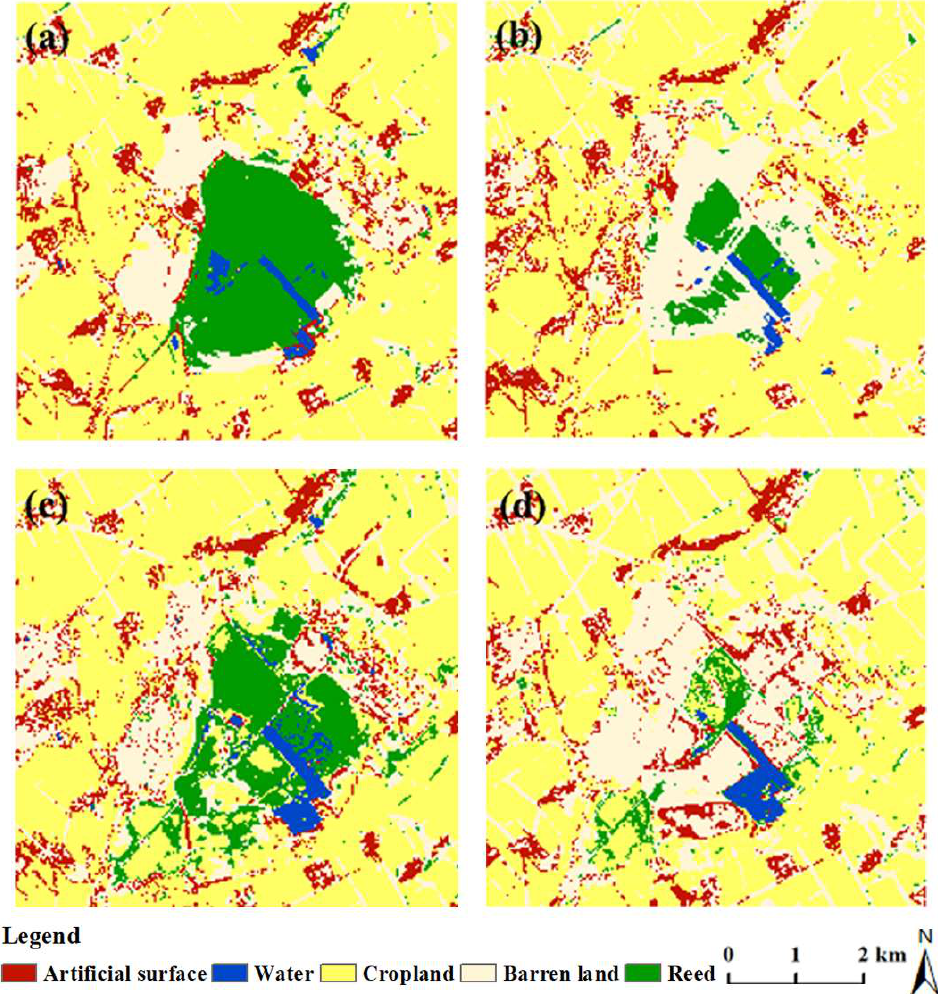
Figure 5. Habitat dynamic changes in HDSL from 2014 to 2017: ( a ) 2014; ( b ) 2015; ( c ) 2016; ( d ) 2017. Table 4. Overall accuracy and kappa coefficient of HDSL from 2014 to